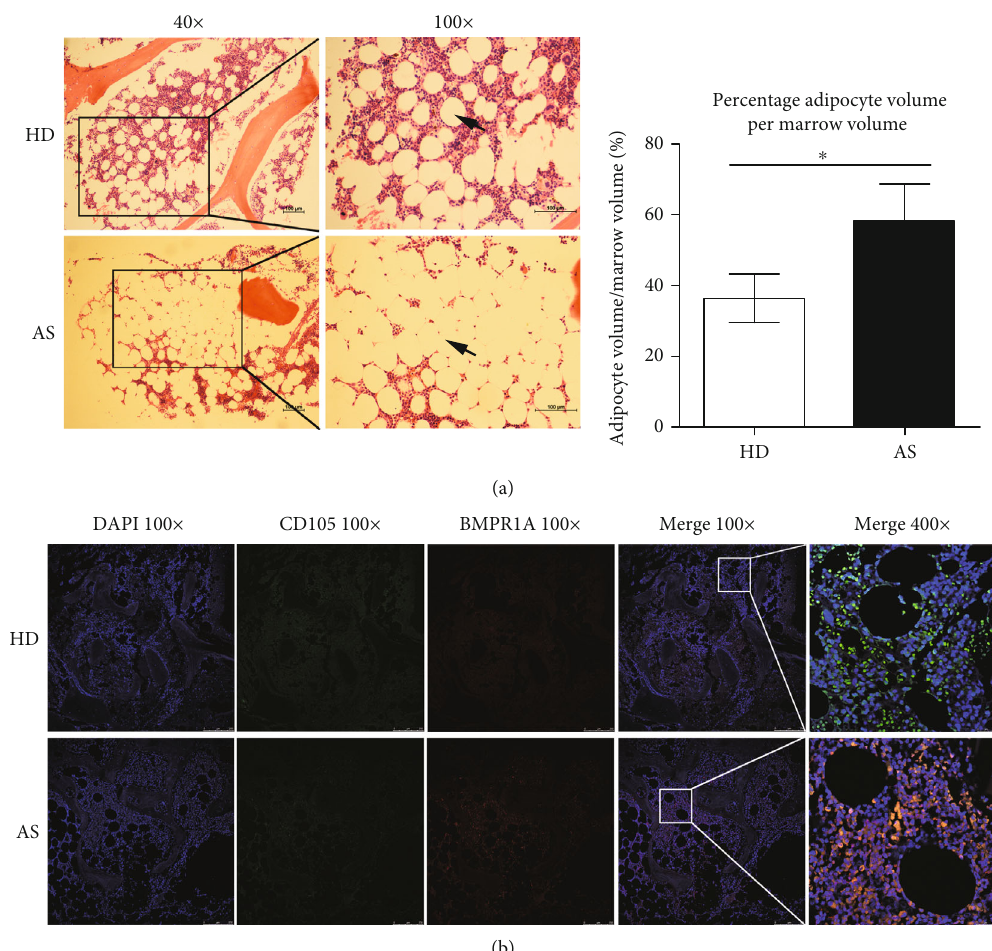
Figure 6: Higher fat content and BMPR1A expression were observed in bone marrow from patients with AS. (a) The bone marrow fat content in patients with AS ( n = 10 ) and healthy donors ( n = 11 ) was determined using HE staining (the black bars indicate 100 μ m). Empty holes with round, smooth edges (black arrows) were considered adipocytes. The percentage of adipocyte volume per marrow volume (Ad.V/Ma.V) was calculated and considered the bone marrow fat content. A higher bone marrow fat content was observed in patients with AS than in healthy donors. (b) Bone marrow tissues were double-stained with antibodies against BMPR1A and CD105. MSCs in the bone marrow tissues expressed both CD105 and BMPR1A, and patients with AS exhibited higher BMPR1A expression than healthy donors. Values are presented as the means ± SDs . ∗ P < 0 : 05 for the di ff erences between HDMSCs and